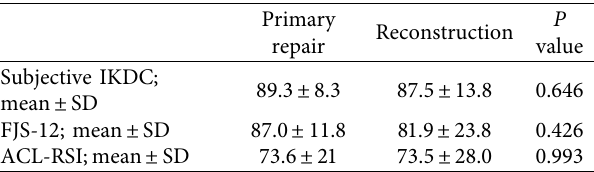
Table 3: Patient-reported outcomes of those treated with primary ACL repair and ACL